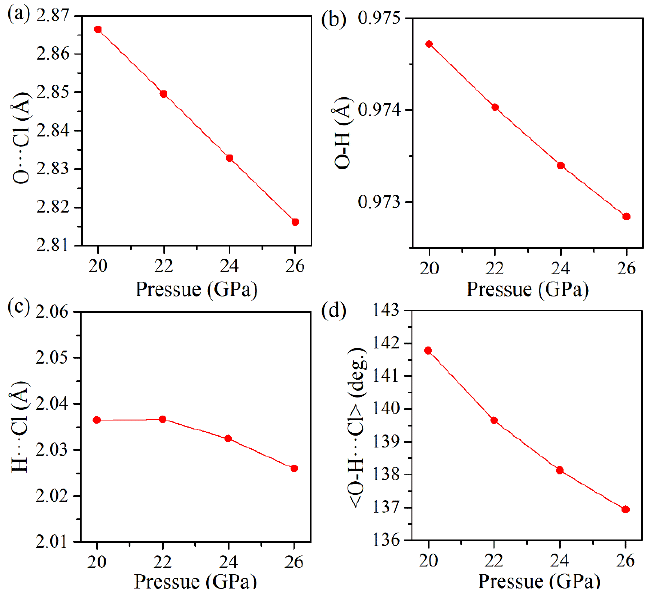
Figure 9. ( a–d ) The evolution of the calculated bond lengths with pressure for H − O, H···Cl, O − Cl, and the bond angles <O − H···Cl> in the orthorhombic phase. and the bond angles <O–H ··· Cl> in the orthorhombic